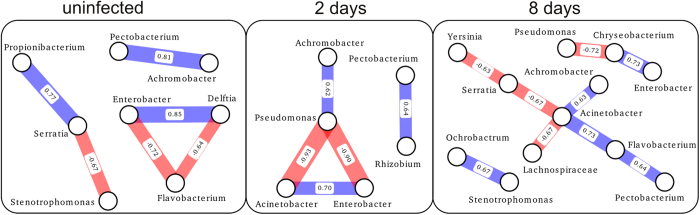
Genera level bacterial correlation networks during P. atrosepticum infection for Experiment 2. Each network was inferred by analyzing the fractional abundance of bacteria with one set of individual potatoes using SparCC58. Connections between nodes give the correlations between genera that form greater than 0.2% of the bacterial population in any given potato within one set. Only connections with correlation values >0.6 and pvalues < = 0.04 are included in the network. Red indicates a negative correlation and blue indicates a positive correlation and the width of each edge is proportional to the pvalue. The most significant relationship is the antagonistic triangle between Pseudomonas, Acinetobacter, and Enterobacter that emerges two days after infection.